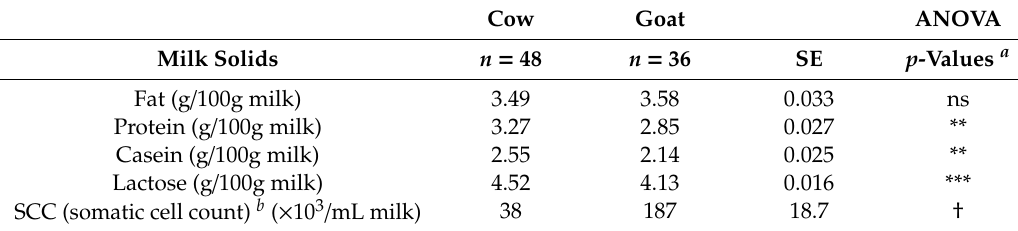
Table 1. Means (and average SE) and ANOVA p -values for the basic composition of cow and goat retail milk collected throughout the study. Cow Goat ANOVA Milk Solids n = 48 n =